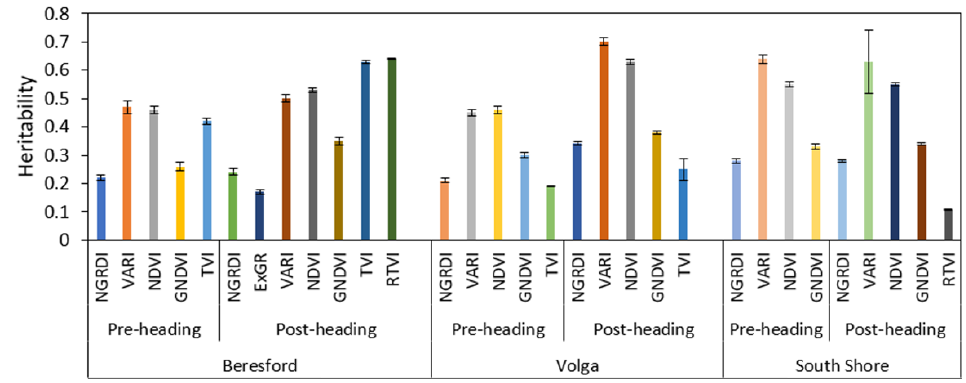
Figure 7. Bar plot representation of broad-sense heritability estimates for vegetative indices collected from pre-heading and post-heading phases across all three locations. (Only the VIs with significant heritability estimate at 95% CI are presented in the figure).